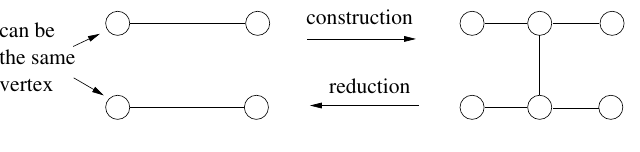
Figure 1: The basic edge insertion